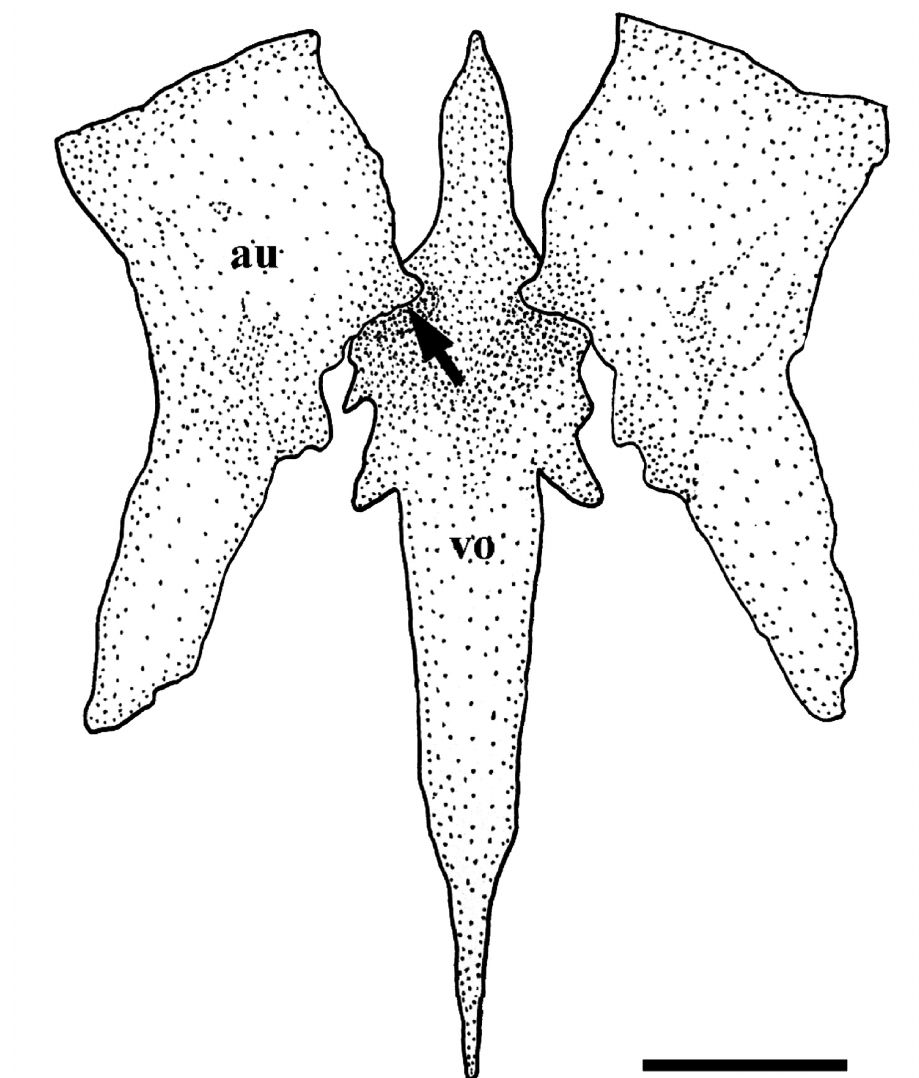
FIGURE 2 | Ventral view of the autopalatine (au) and vomer (vo) of Scleronema operculatum (UFRGS 19654) showing the articulation ventrally located between these two bones (black arrow). Scale bar = 1